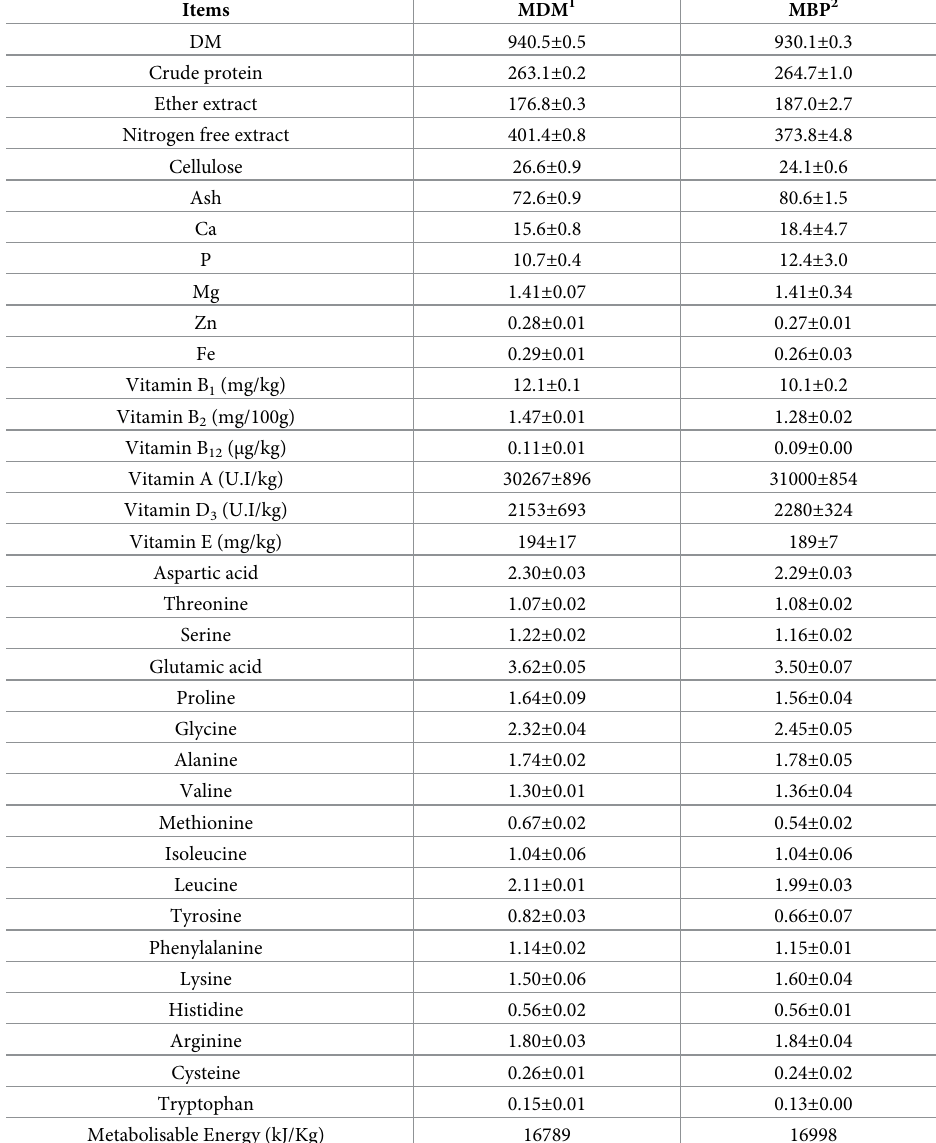
Table 2. Chemical composition (g/kg, as-fed basis), mineral content (g/kg, as-fed basis), vitamin content and amino acid content (g/100 g, as-fed basis) of the two diets (MDM = Mechanically Deboned Meat diet and MBP = Meat By-Product diet; mean ±